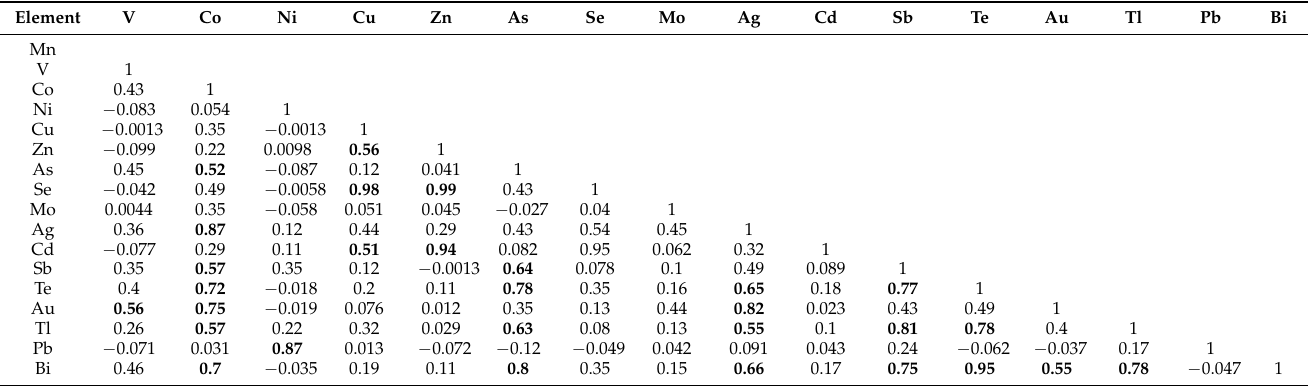
Table 6. Pearson coefficients of correlation of trace elements in early generations of